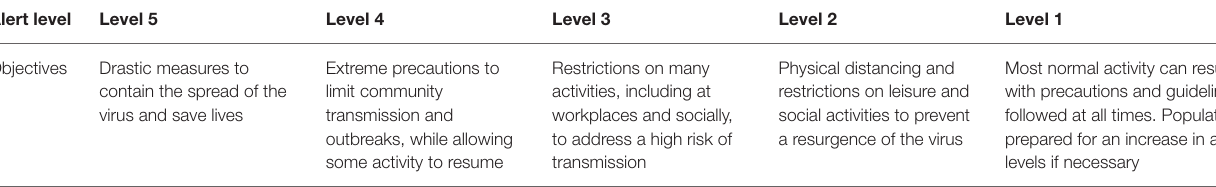
TABLE 1 | Summary of alert levels in South Africa [adapted from SA Coronavirus